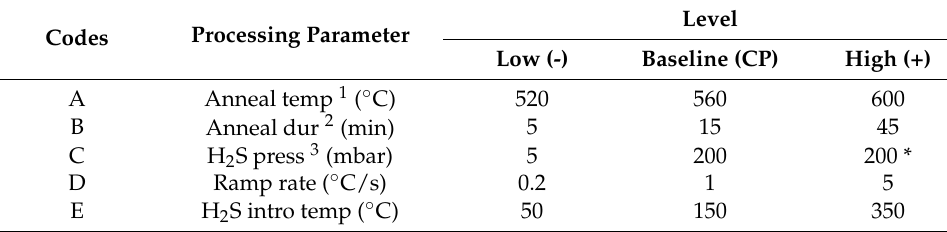
Table 1. Processing parameters and respective levels.